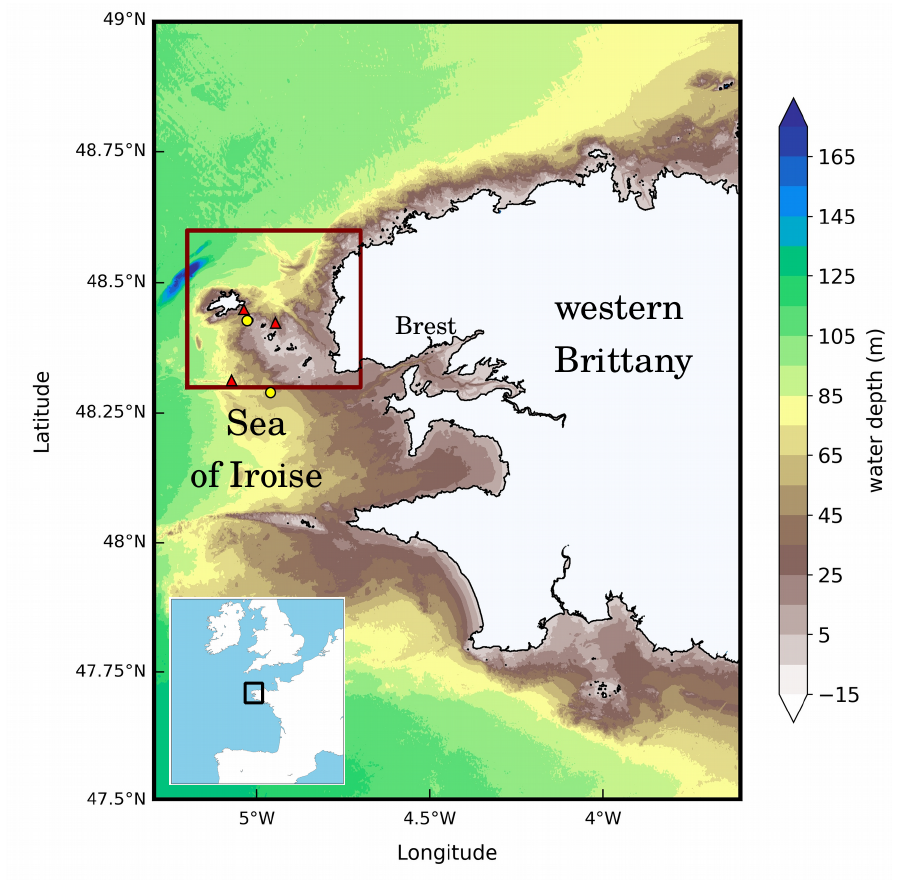
Figure 1. Mean water depth of western Brittany. Locations of current meters and wave buoys exploited in resource assessments are indicated with red triangles and yellow circles,